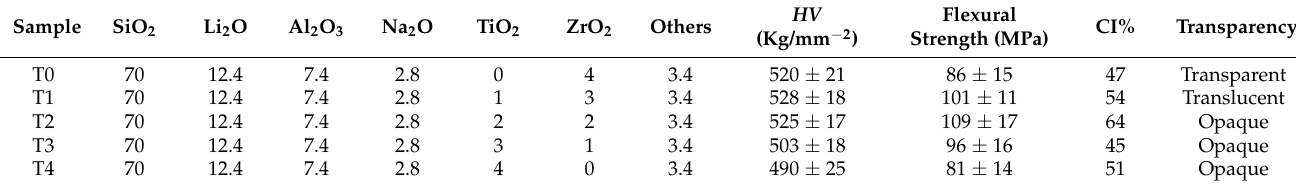
Table 1. Compositions (in wt%) and properties of the LAS GCs